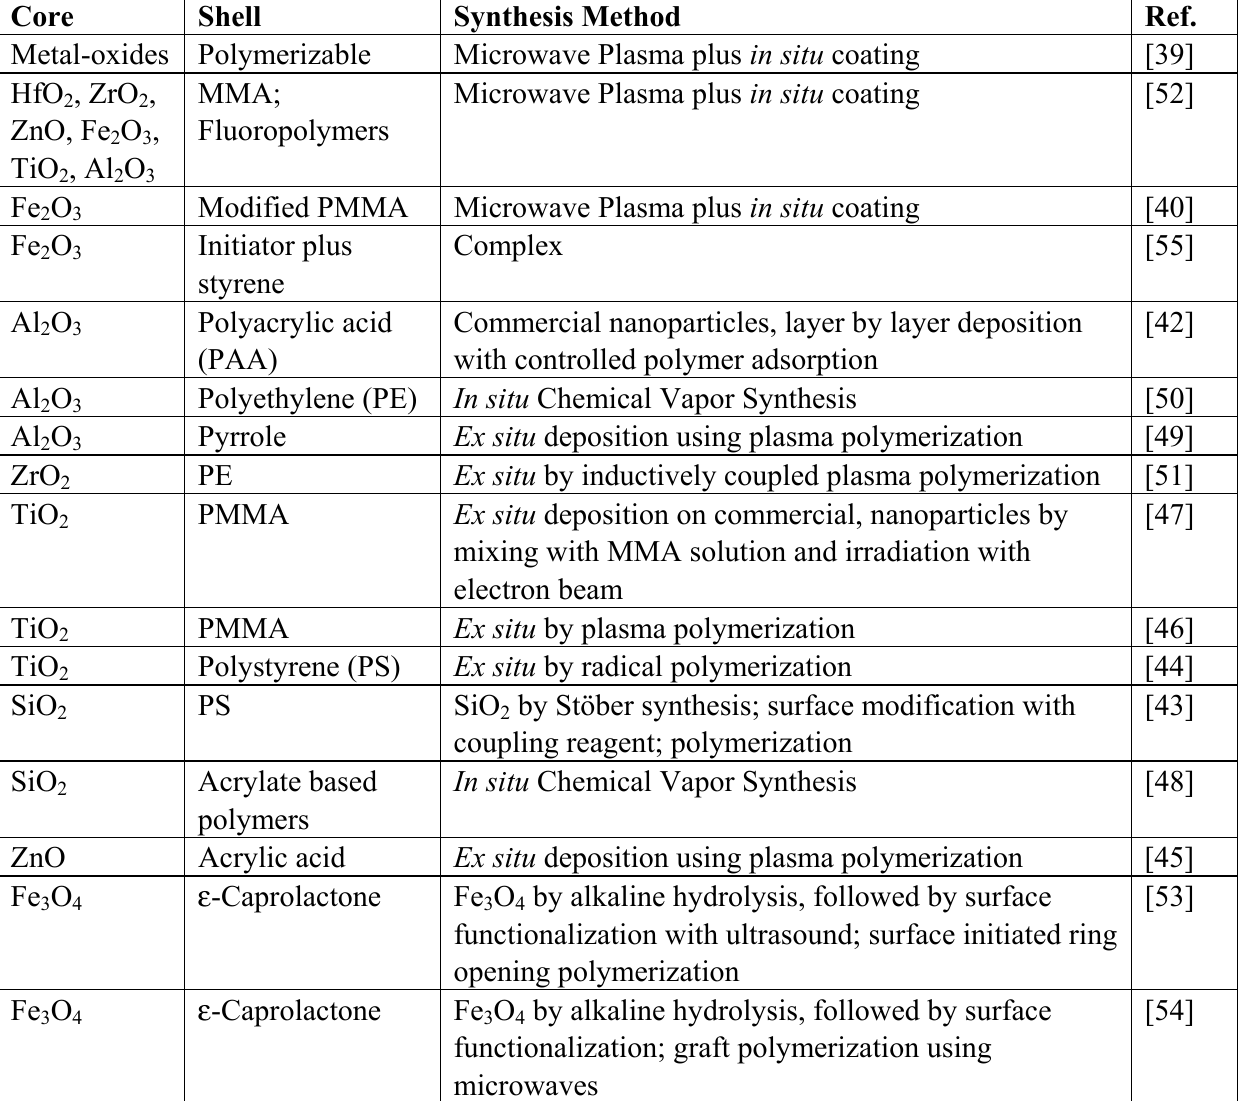
Figure 4 visualizes exemplarily inorganic/organic core/shell nanoparticles by a transmission diameter; the polymer coating is around 2 nm in thickness. Table 1. Portfolio of various core/shell hybrid nanoparticles with a ceramic core and an organic shell. Core Shell Synthesis Method